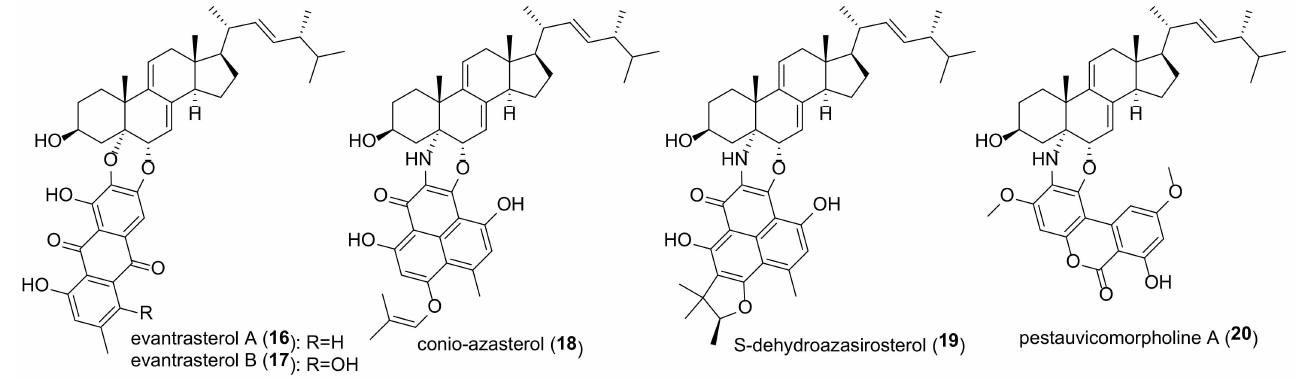
Figure 4. Structures of natural hybrids of 9-dehydroergosterol with polyketides.